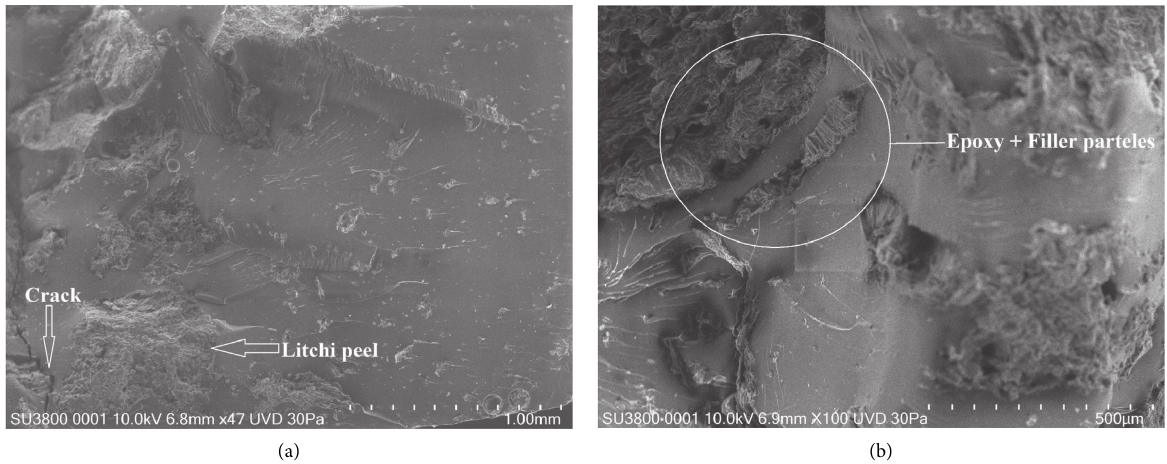
Figure 5: SEM image of broken surface of epoxy composite, 20 wt% of litchi peel at different magnifications. 19.619.82020.220.420.620.82121.221.421.621.8